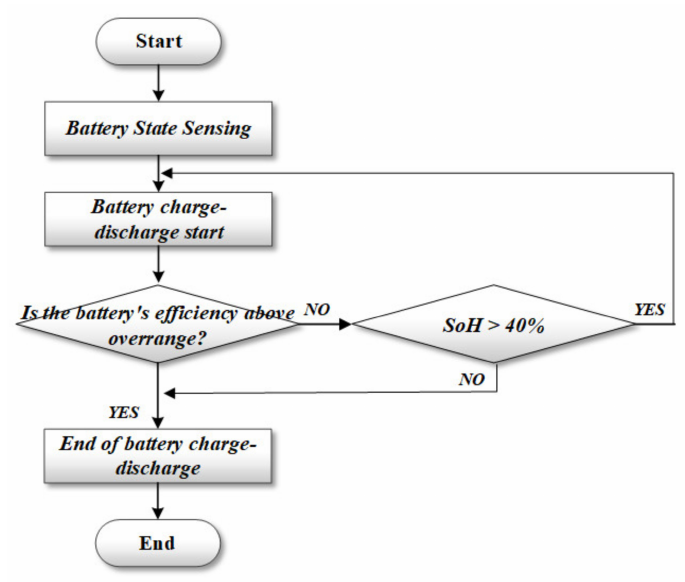
Figure 9. Proposed fault diagnosis